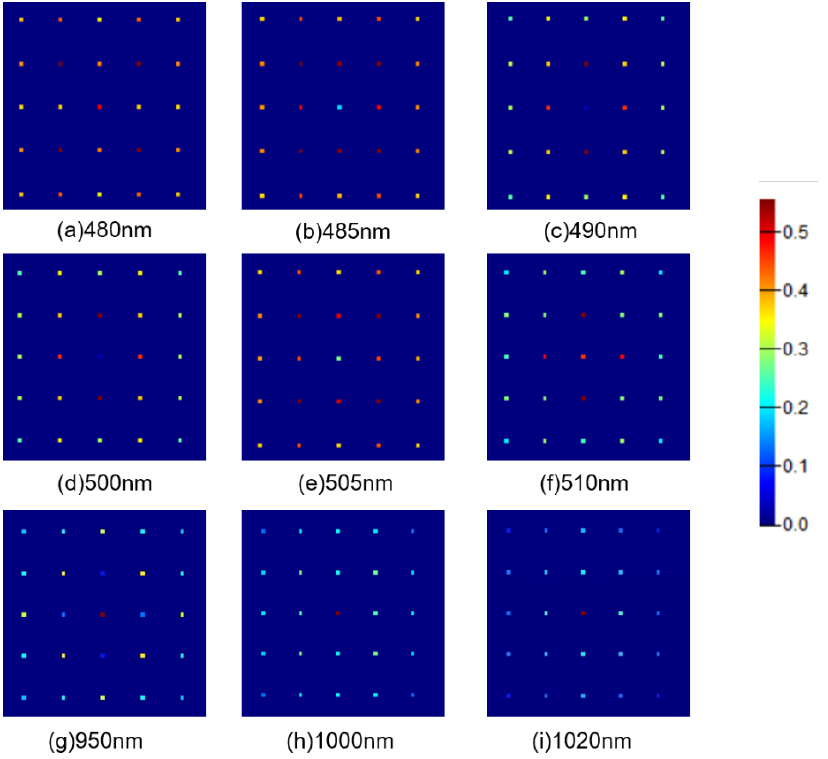
Figure 9. ( a – i ) Normalized light intensity distribution of the diffraction spots when plane waves with different wavelengths are incident.